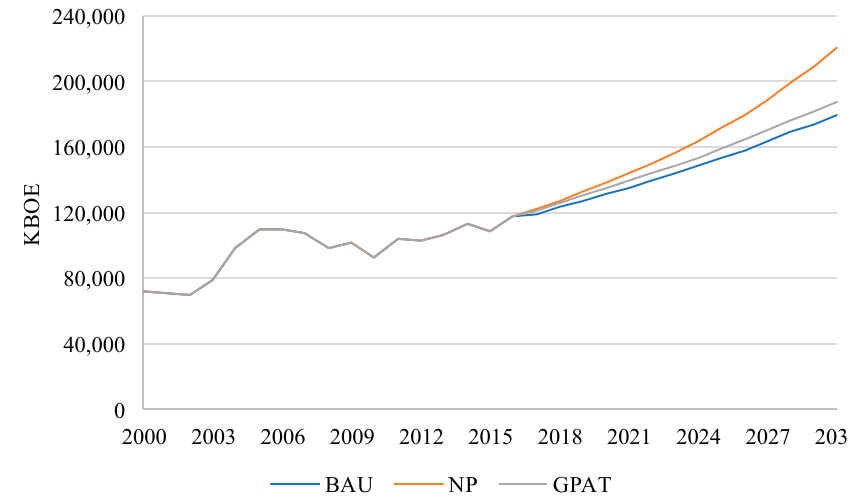
Figure 2. Primary energy production, Business as Usual (BAU), National Policies (NP) and Global Policies and Trends (GPAT) scenarios for 2030.